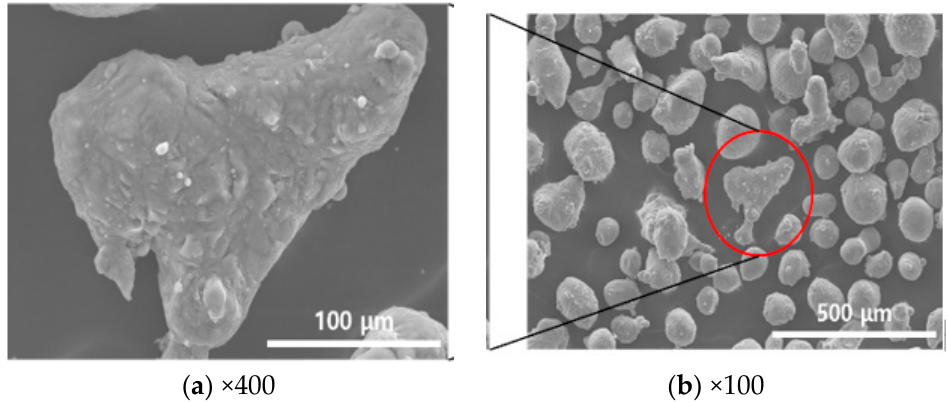
Figure 9. FE-SEM images of magnesium powder used in different magnifications, × 400 ( a ) and × 100 ( b ).